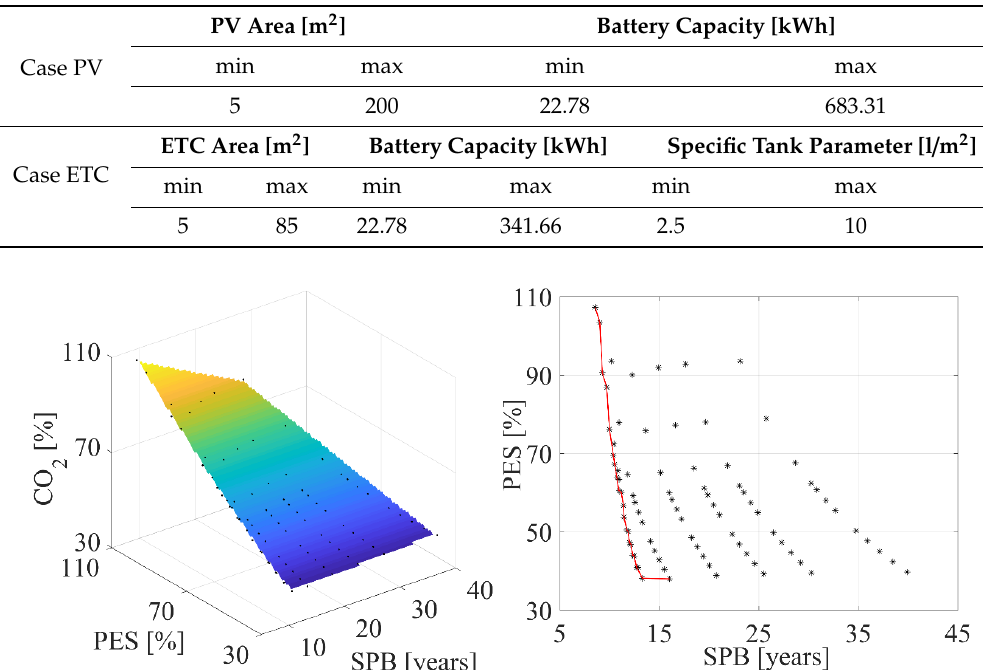
Table 9. Parameter varied during the optimization analysis, PV layout and ETC playout.